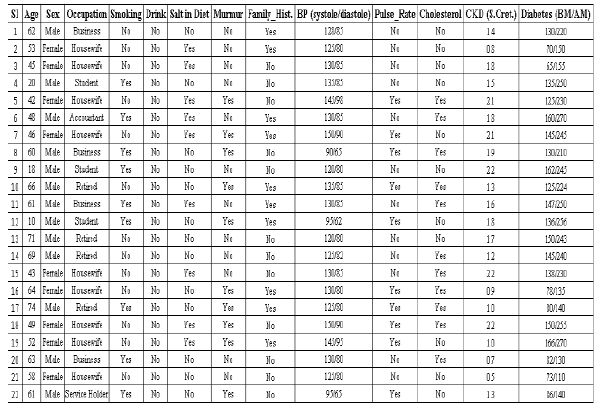
Table 10. Sample dataset of diabetic blood pressure patients.